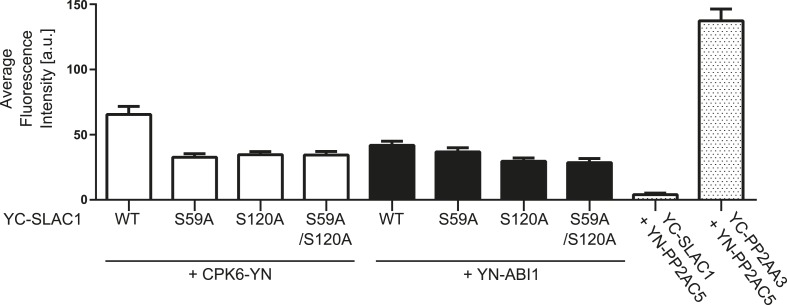
BiFC fluorescence intensities are altered for CPK6 and ABI1 co-expression with SLAC1-WT, SLAC1S59A, S120A, and S59A/S120A.Quantitative BiFC experiments showed that CPK6-YN + YC-SLAC1-WT derived fluorescence signals are significantly decreased when CPK6-YN was expressed with YC-SLAC1-S59A, YC-SLAC1-S120A, or YC-SLAC1-S59A/S120A (p < 0.0001; unpaired t-test). YC-SLAC1-S59A expression with YN-ABI1 did not result in a significant decrease of the average fluorescence intensity in comparison with YC-SLAC1-WT and YN-ABI1 co-expression (p = 0.2647; unpaired t-test). Signal intensities significantly decreased when YN-ABI1 was co-expressed with YC-SLAC1-S120A or YC-SLAC1-S59A/S120A vs co-expression with YC-SLAC1-WT (p < 0.005; unpaired t-test). The data for CPK6-YN + YC-SLAC1-WT, YN-ABI1 + YC-SLAC1-WT, YN-PP2AC5 + YC-SLAC1-WT and YN-PP2AC5 + YC-PP2AA3 are also shown in Figure 4B. Average fluorescence intensities were determined of leaf areas which were chosen randomly in white light (±SEM; n = 40 images per condition).